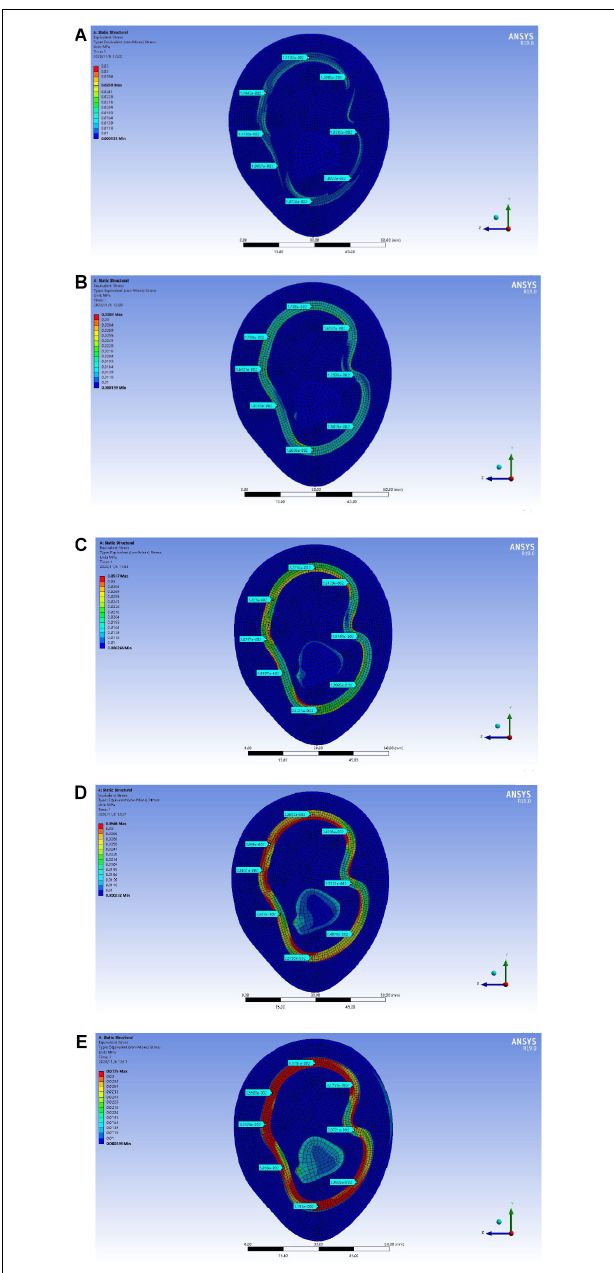
FIGURE 14 | Point selection picture of the lymph and blood layers of the forearm model with different external pressure loads: (A) 002 MPa external